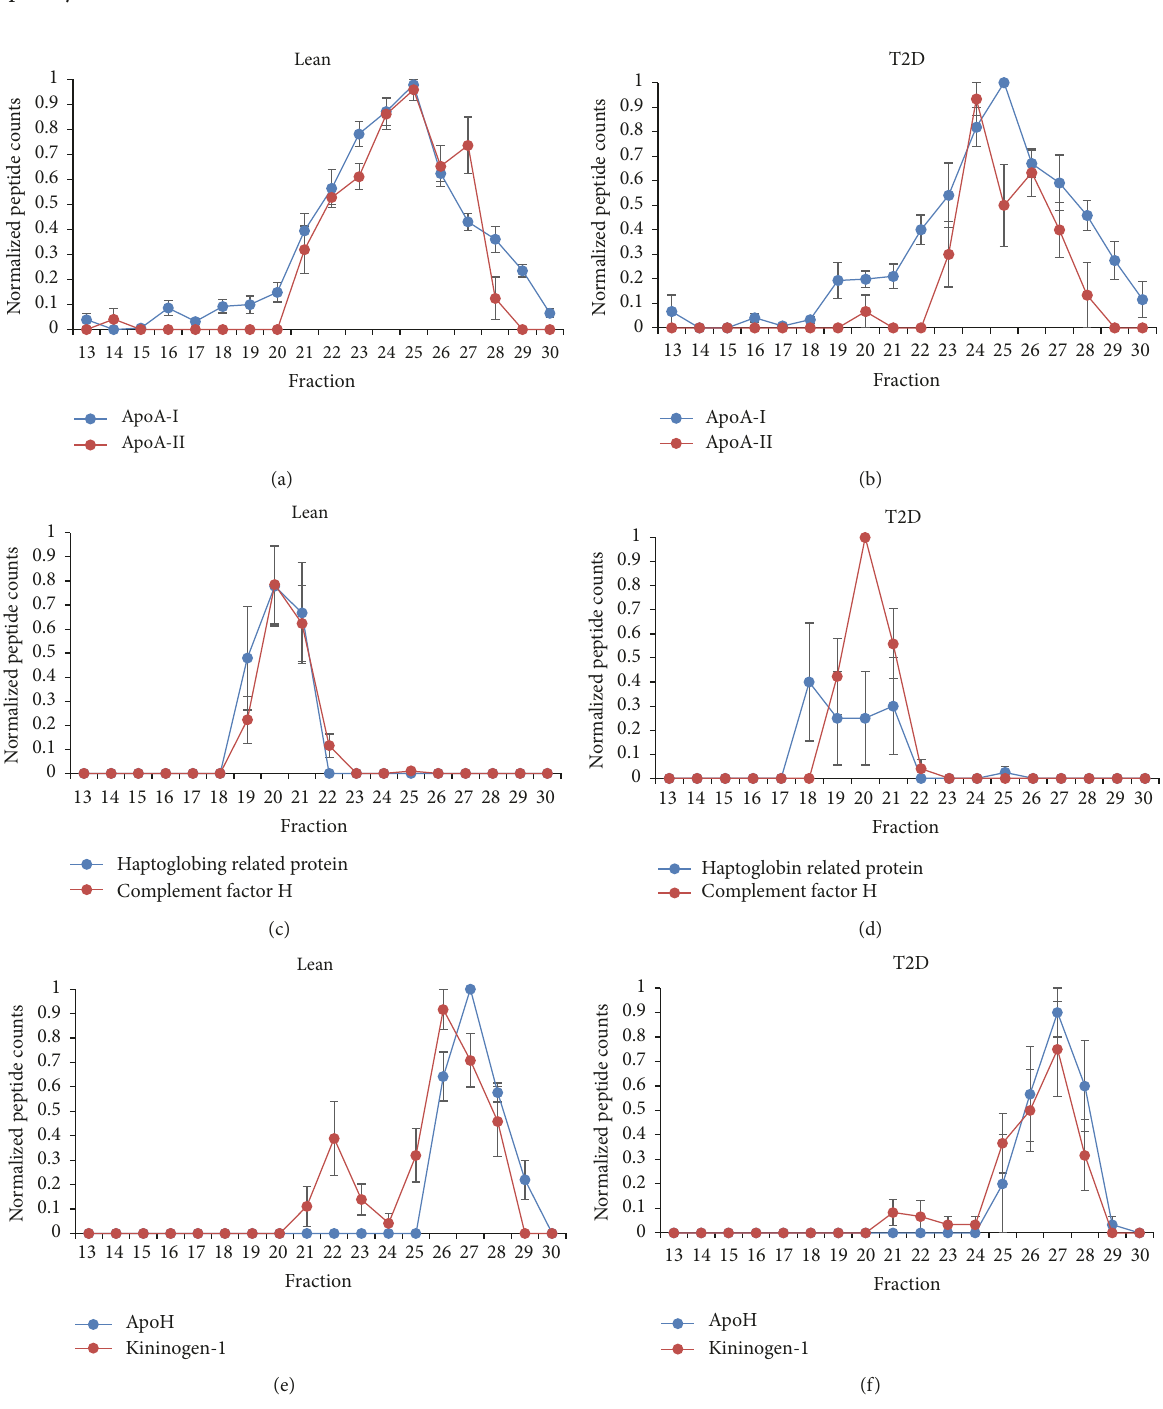
Figure 5: Comigration patterns of protein pairs . (a-b) apoA-I and apoA-II, (c-d) haptoglobin-related protein and complement factor H, and (e-f) apoH and kininogen-1, from lean and T2D groups. Spectral counts were normalized by dividing maximum value across all fractions. Data are mean and standard deviation of normalized spectral